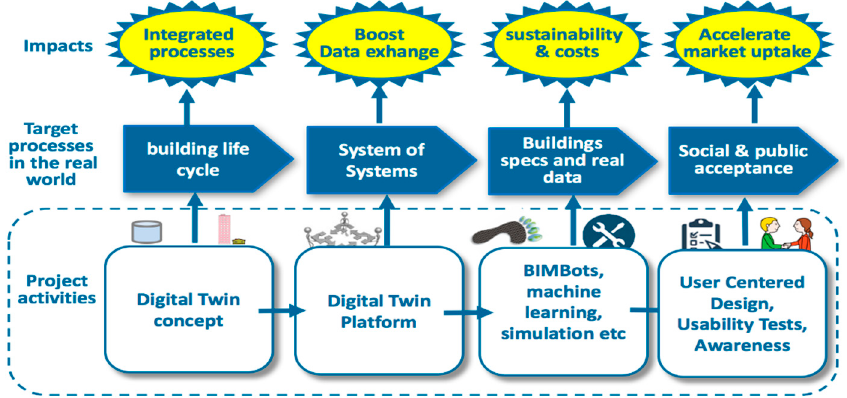
Figure 1. activities and